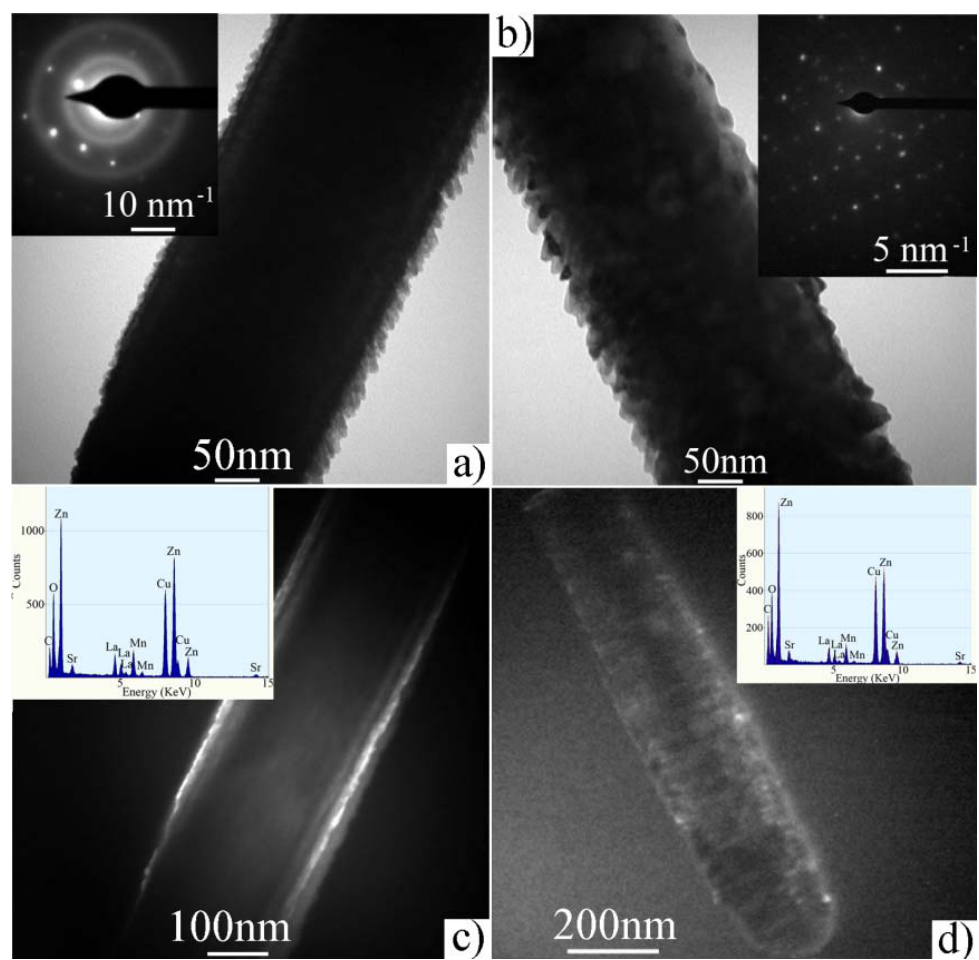
Figure 9. TEM image of as-deposited ZnO/LSMO composite nanorod: ( a ) and ( b ) bright field, ( c ) and ( d ) dark field. ( a ) and ( c ) correspond to as-deposited ZnO/LSMO, ( b ) and ( d ) correspond to annealed ZnO/LSMO. The insets in ( a ) and ( b ) show the corresponding electron diffraction pattern. The insets in ( c ) and ( d ) show the corresponding EDS